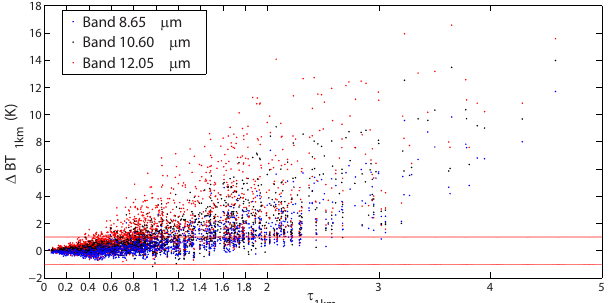
Figure 19. Brightness temperature differences, 1 BT 1km , viewed at the nadir between BT3D 1km and BT1 − D 1km as a function of the optical thickness at 1km ( τ 1km ) for the three channels of the IIR and for 2000 pixels per band. The two red lines correspond to the instrumental accuracy of the IIR of about ±